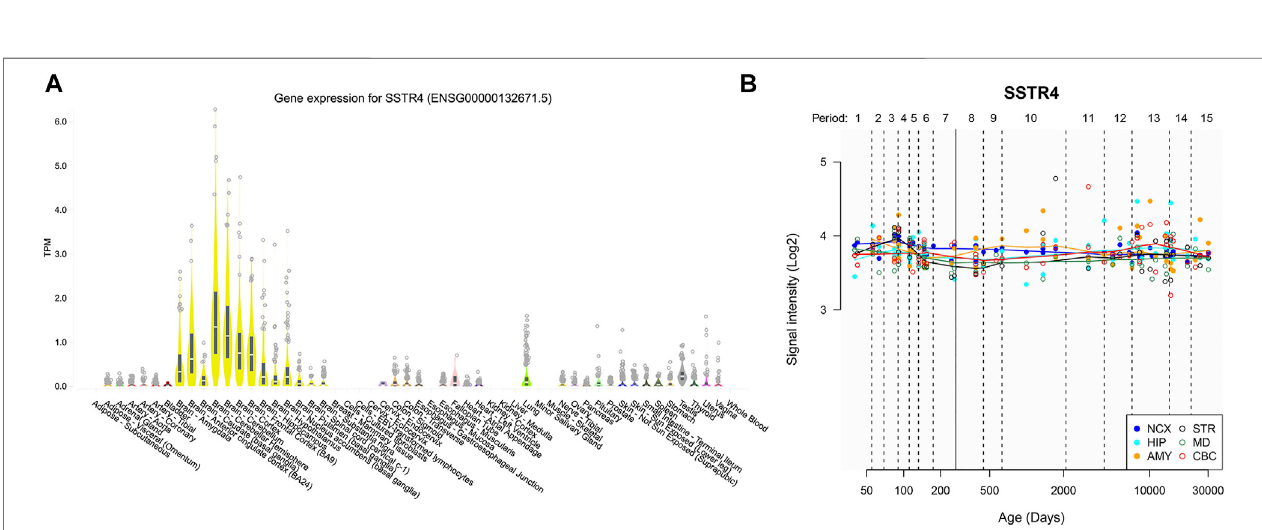
FIGURE 3| The methylation difference ofthe SSTR4 promoter region in 10paired siblings withmicroarray and case-controls with pyrosequencing. (A) Box plot of the methylation value of the SSTR4 promoter region with microarray and 10 paired siblings. (B) Box plot of the methylation value of the SSTR4 promoter region with pyrosequencing and case-controls. p p < 0.05, pp p < 0.001.